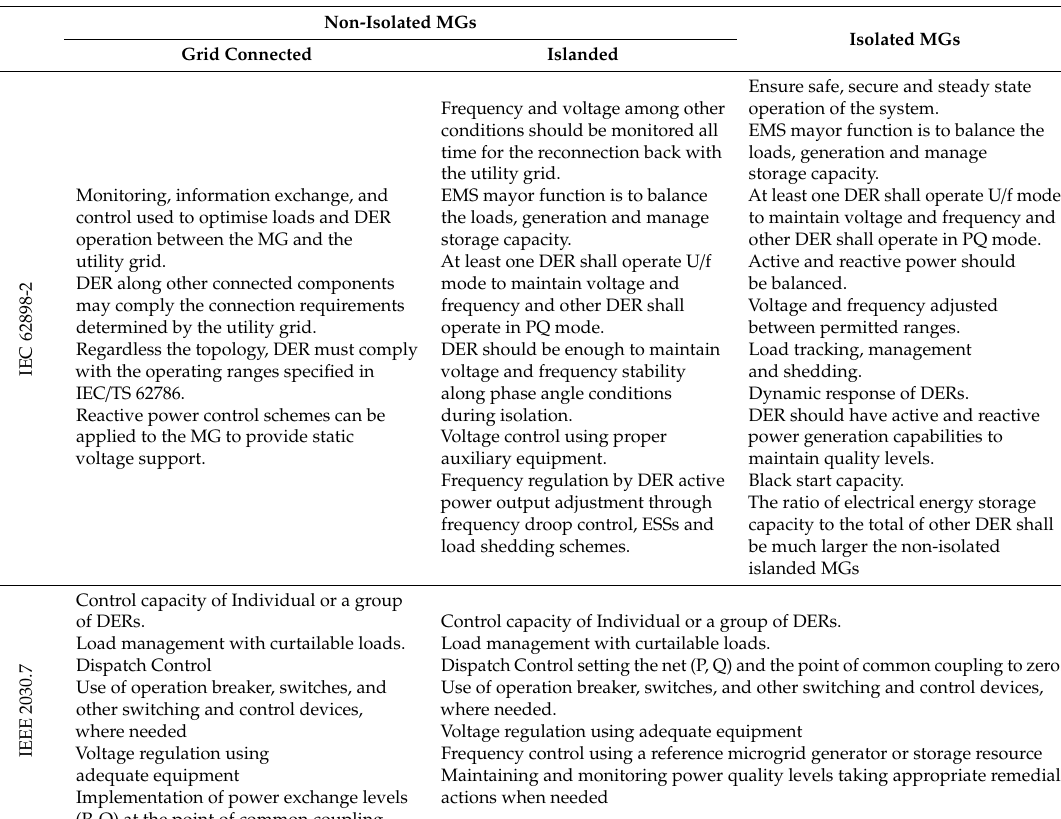
Table 1. Comparative operation and control strategies between IEC 62898-2 [57] and IEEE 2030.7